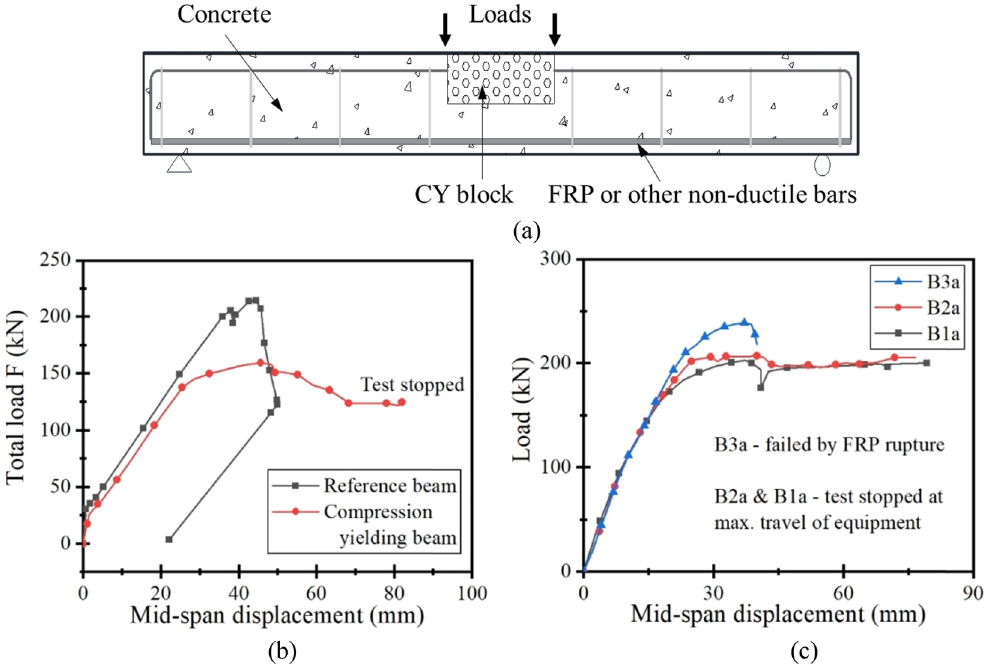
Figure 1: CY structural system [ 7,11 ] : ( a ) CY beam with non - ductile reinforcement, ( b ) responses of test specimens, and ( c ) load vs mid - span